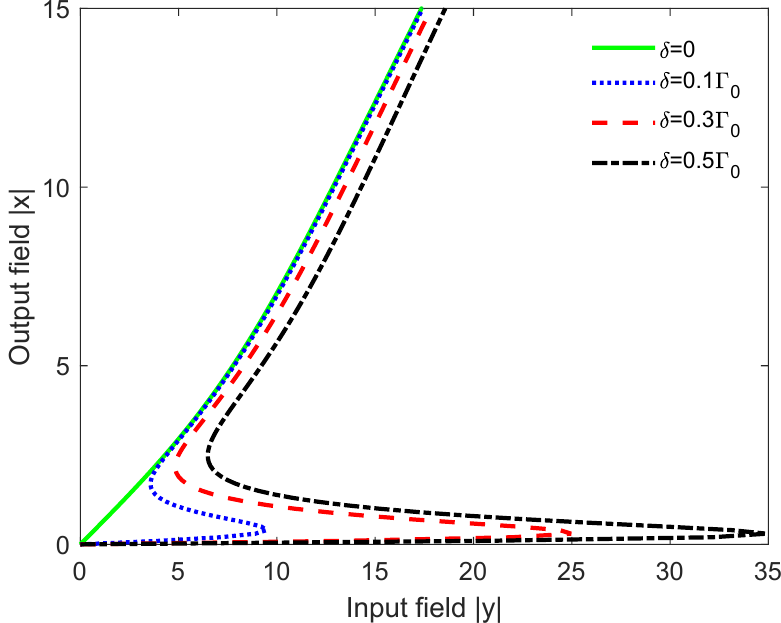
Figure 3. Plots of the input–output field curves for the quantum sample (emitter + metasurface) for different values of emitter-metasurface distance δ . We take ¯ ω = 0.632 ω p , ω 32 = Γ 0 , r = 0, C = 100 and d = 0.8 c / ω c